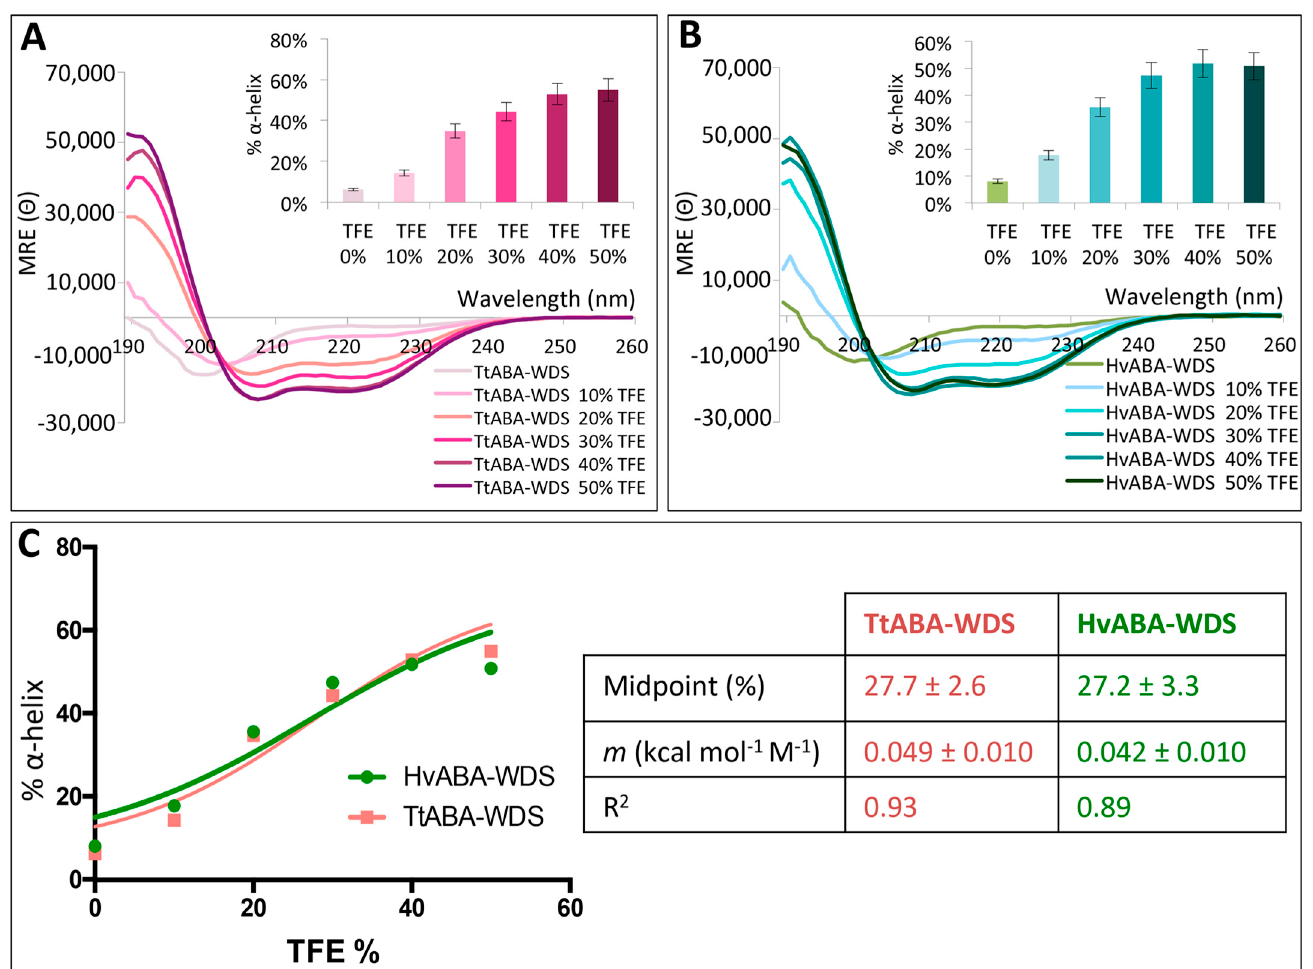
Figure 6. Far-UV CD spectra of HvABA-WDS ( A ) and TtABA-WDS ( B ) in the presence of increasing concentrations of TFE at 20 °C. Proteins were at 0.12 mg/mL in 10 mM sodium phosphate pH 7. Data are representative of one out of two independent acquisitions. The insets show the α -helical content as derived as described in Materials and Methods (see Equation (6)). MRE: molar residue ellipticity ( Θ ) in deg cm 2 dmol − 1 . ( C ) Transition diagrams of HvABA-WDS and TtABA-WDS. The α -helical content of the two domains, as derived from the CD spectra, was plotted as a function of the TFE concentration and data were fitted to sigmoidal curve, corresponding to a two-state transition. The inset shows the midpoint of transition and m values, as derived from the fitting, along with the quality of the fitting.